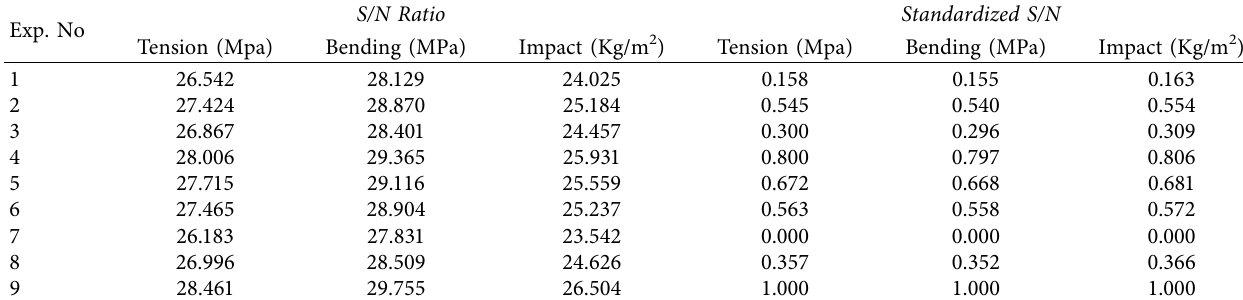
Table 4: S/N and consistent S/N